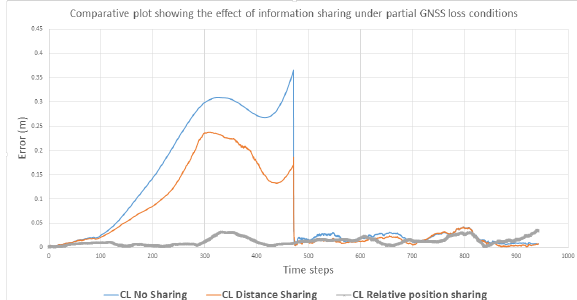
Figure 3: Error comparison for the position of a fault node which temporarily loses its GNSS signal for the case with and with- out information sharing. It also compares the cases for sharing relative range vs sharing relative position. The relative range ac- curacy in this case is assumed to be 2cm.